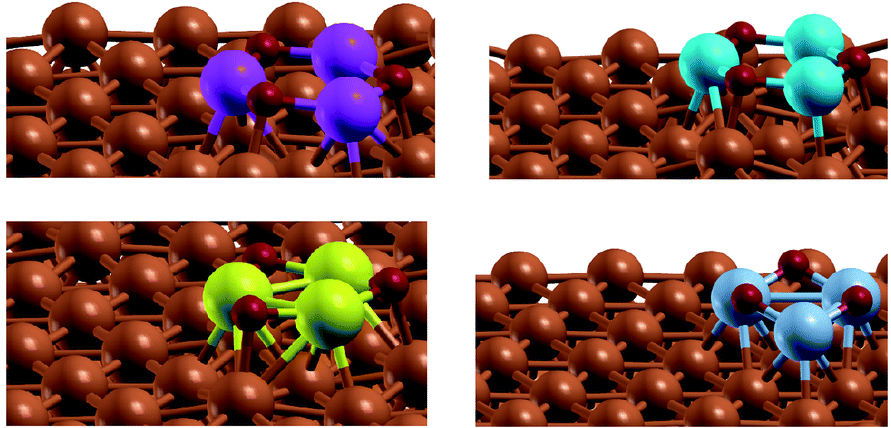
Figure 7. Catalyst models of M 3 O 3 -doped Cu. Reprinted with permission from [35]. Copyright (2017) Royal Society of Chemistry.